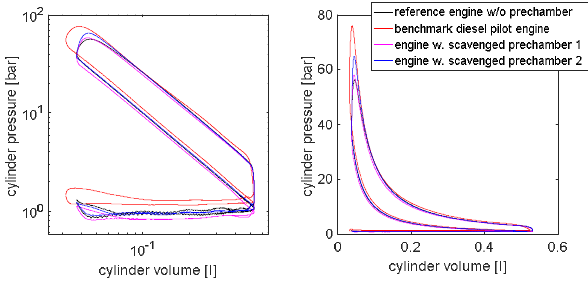
Fig. 24. Cylinder pressure versus cylinder volume for the operating point (1500 rpm/100 Nm), λ = 1.7 and COC = 8 °CA after TDC